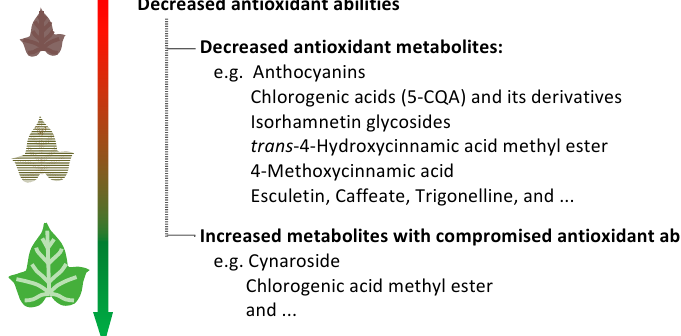
Figure 5. Scheme for the decreased antioxidant abilities in sweetpotato JRF leaves.